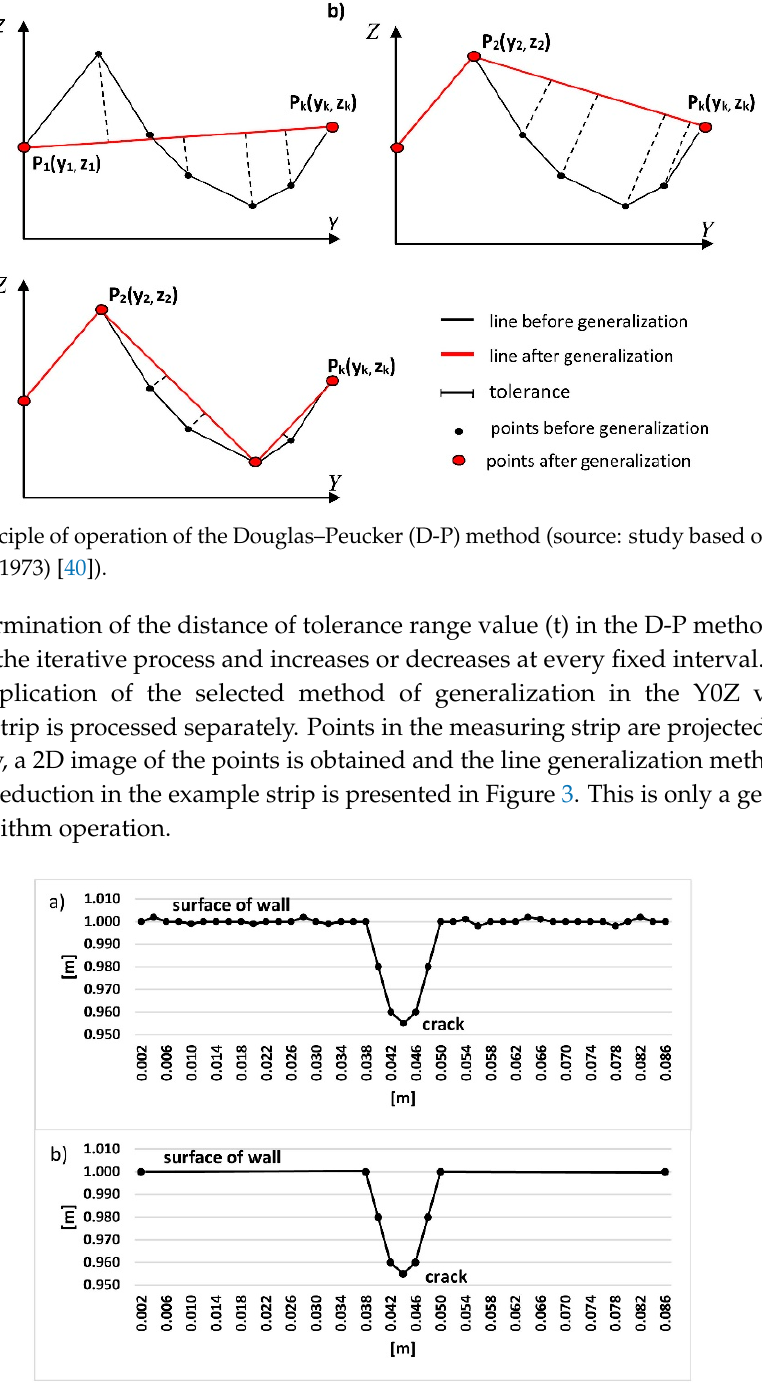
Figure 3. Results of the reduction process in measuring strip ( a ) before reduction, ( b ) after reduction.